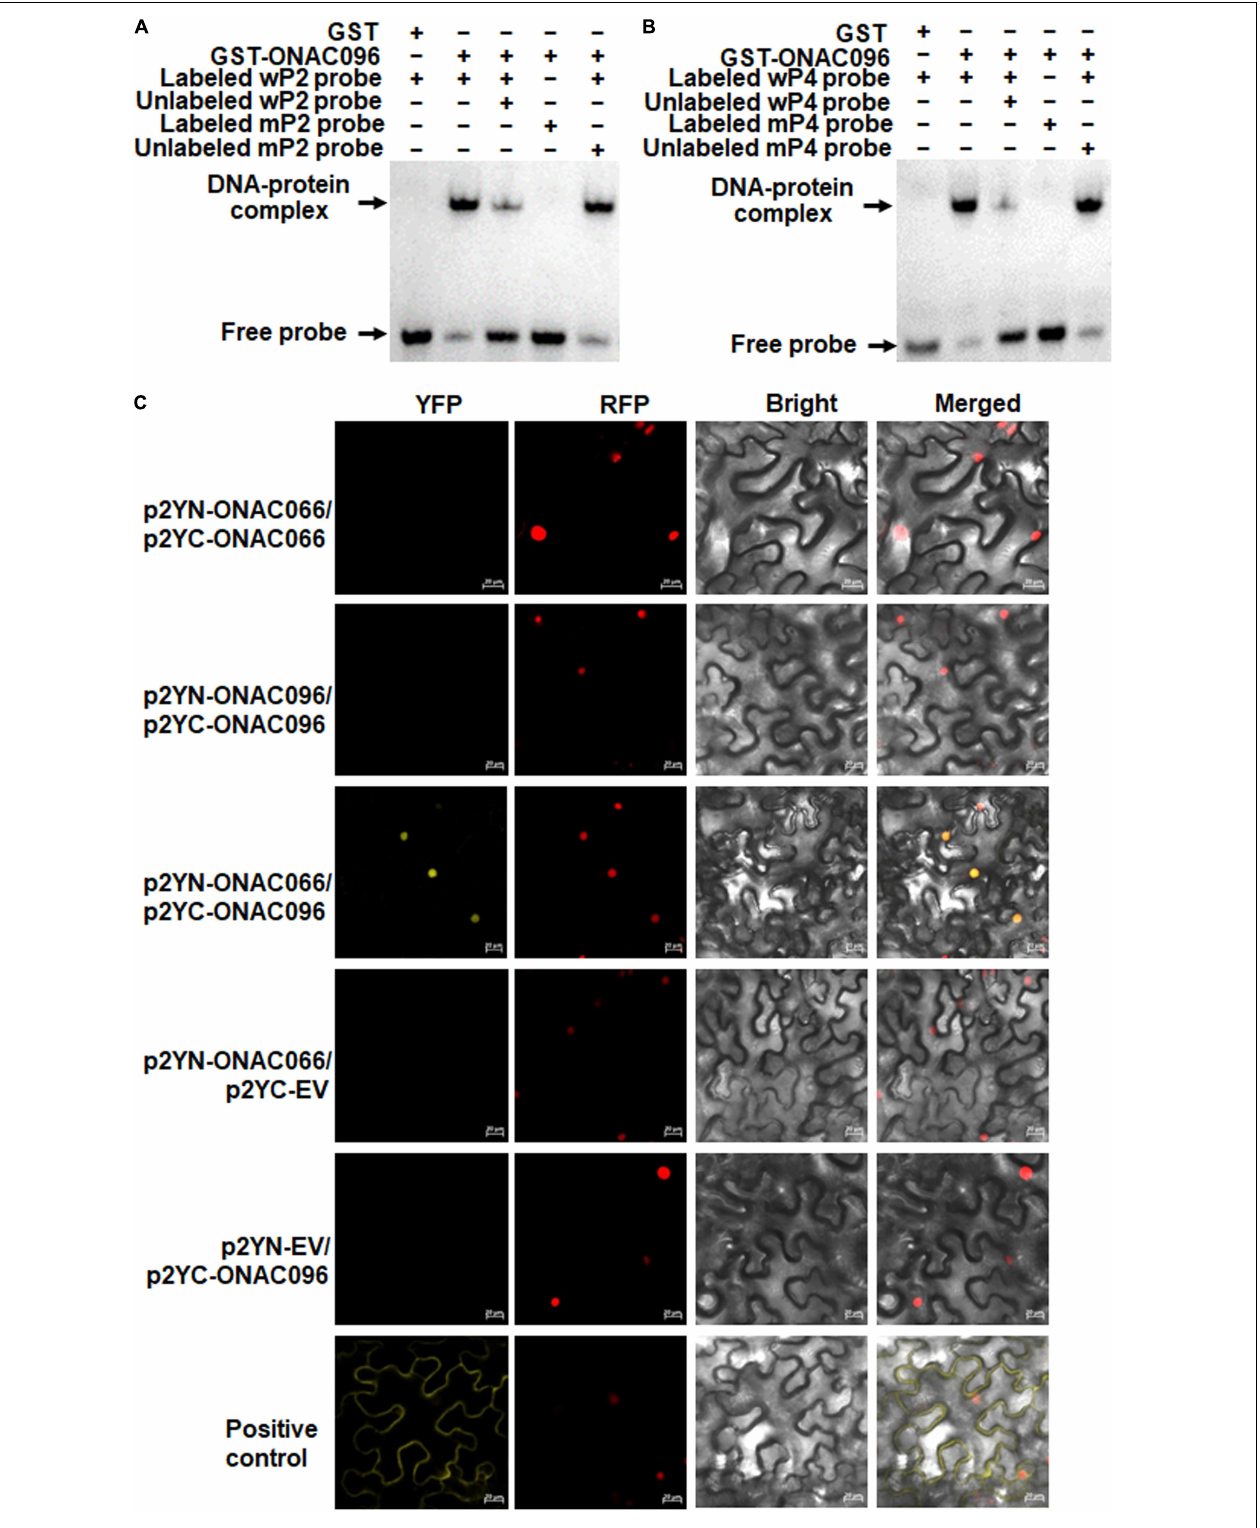
FIGURE 8 | ONAC096 directly binds to the NAC core-binding sites in the OsRap2.6 promoter and interacts with ONAC066. (A,B) , Binding of ONAC096 to the NAC core-binding sites in P2 (A) and P4 (B) regions of the OsRap2.6 promoter. Biotin-labeled wP2/wP4 and mP2/mP4 probes (as the binding assay) or